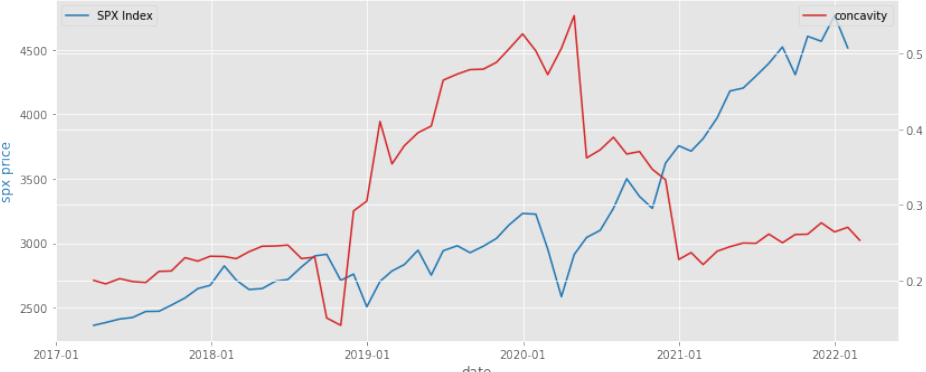
Figure 3. Recent 5-year concavity vs. S&P 500 Index (monthly).